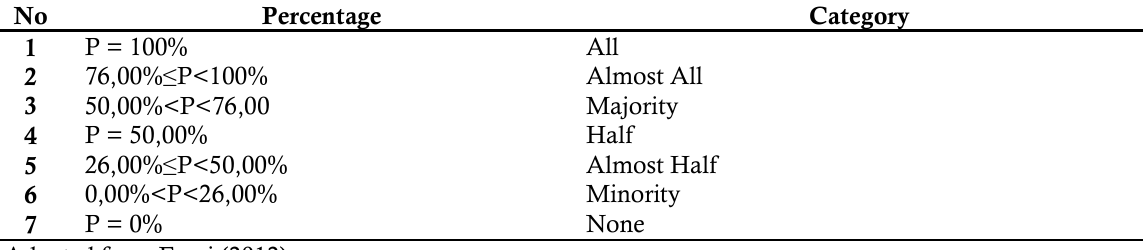
Table 2. Percentage criteria for questionnaire